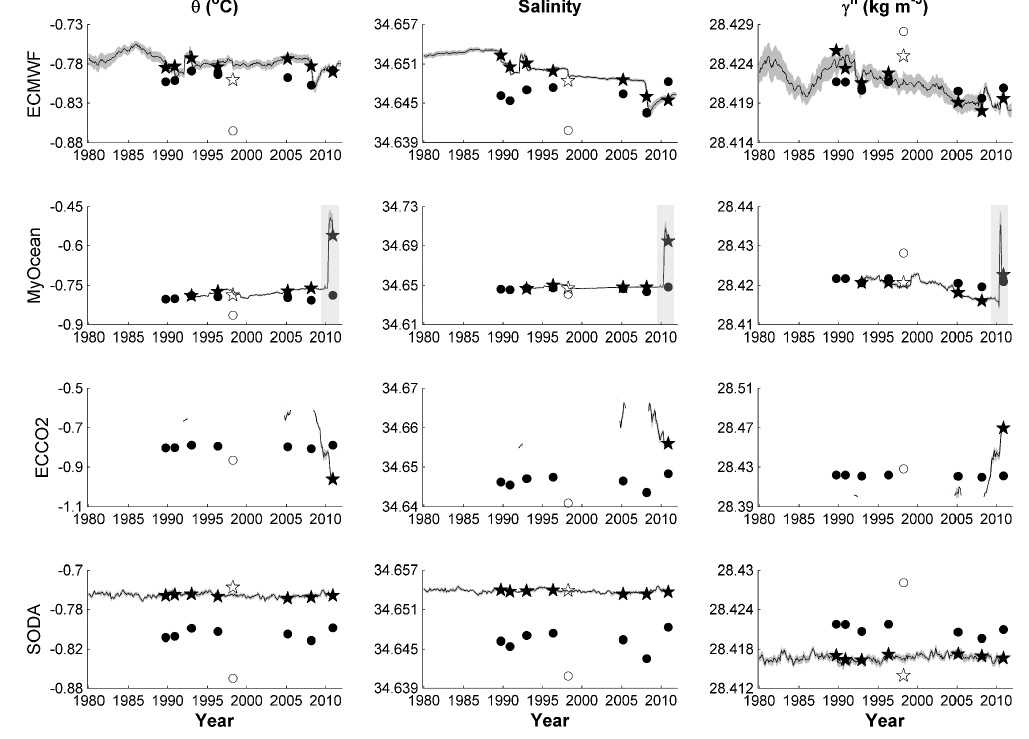
Figure 16. Same as in Fig. 12, but for WSBW. 1157